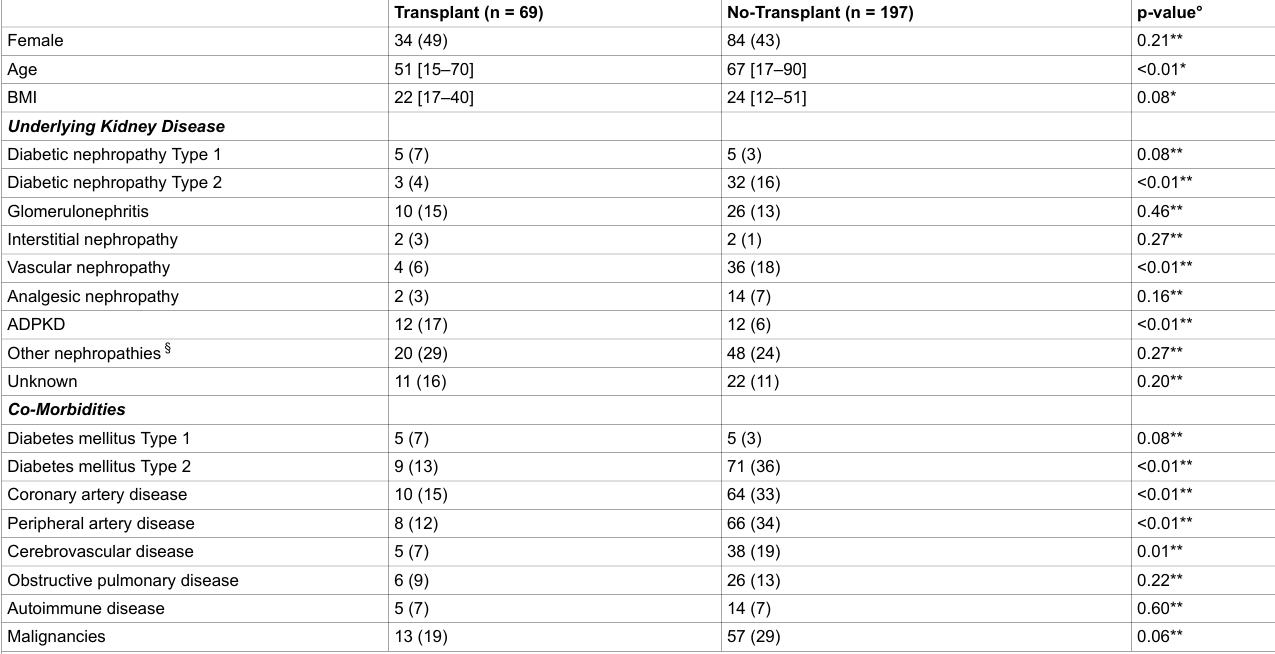
Data are displayed as counts and percentages (%) of 266 patients. Table 4: Baseline characteristics stratified according to transplantation status during the observational